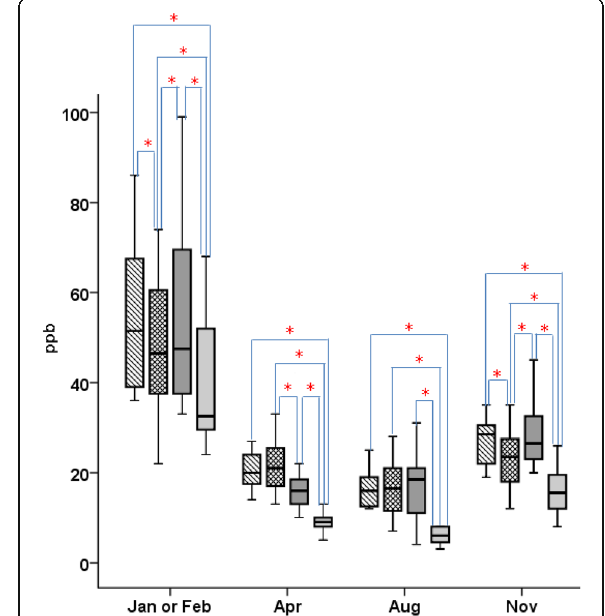
Fig. 2 Comparison of the outdoor SO 2 concentrations in each district in each season. District A: box with stripes, district B: mesh box, district C: black box, district D: gray box; Asterisk indicates statistically significant ( p < 0.05); air quality standard for the mean annual SO 2 concentration: 10 μ g/m 3 (3.8 ppb)